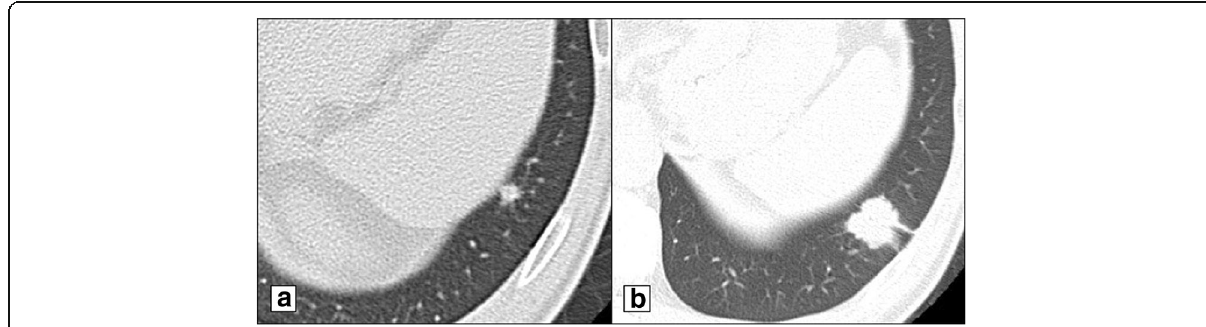
Fig. 1 Imaging studies of the first pulmonary metastasis. Chest CT (53 months after curative resection of the primary pancreatic tumor) shows a tiny nodule at the lower lobe of the left lung ( a ). Follow-up CT (70 months after curative resection of the primary pancreatic tumor) shows that this nodule has enlarged to 2 cm in size with spiculation ( b ). It is difficult to determine whether this nodule is a primary or metastatic tumor on imaging